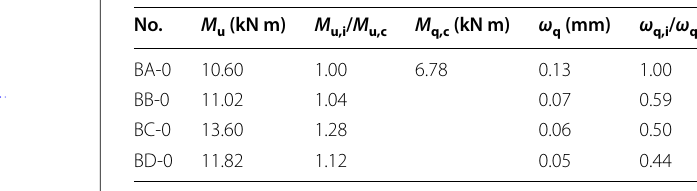
Table 8 Comparison of bending capacities and deflection— taking concrete specimen as control